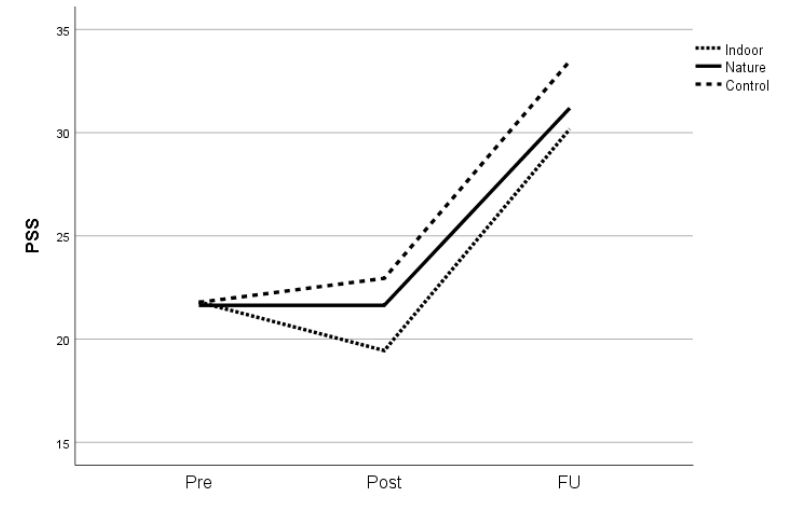
Figure 2. Effects on perceived stress level (PSS). Note. Pre-treatment, post-treatment, and at 3-month follow-up (FU). Dotted line: mindfulness indoors. Solid line: mindfulness in natural setting. Hatched line: control group.